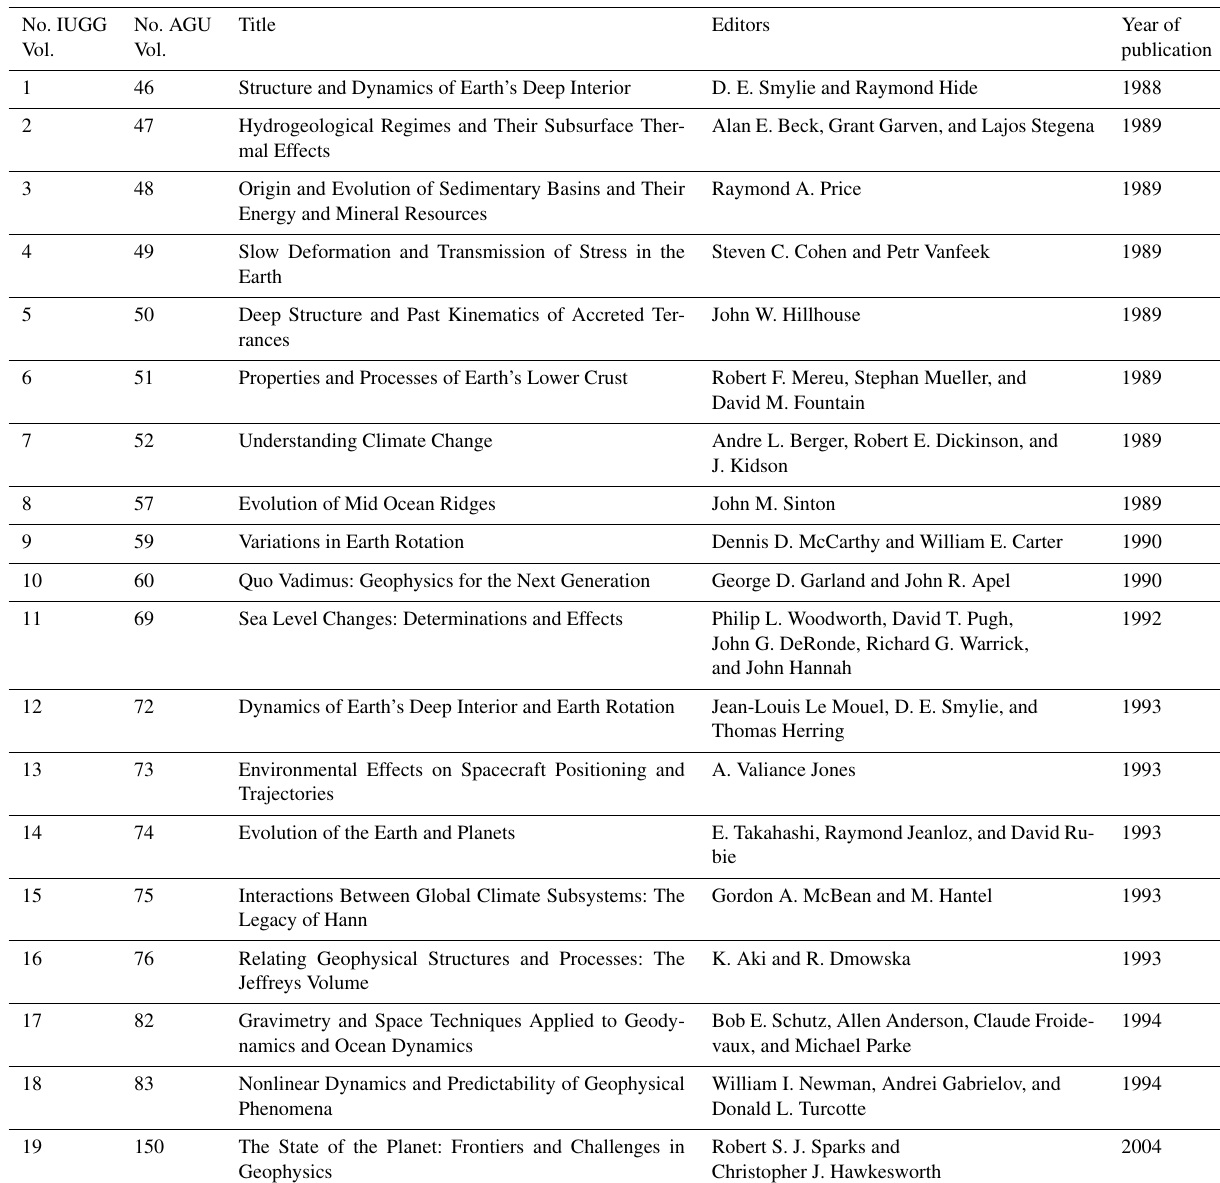
Table B1. AGU Geophysical Monograph series – IUGG